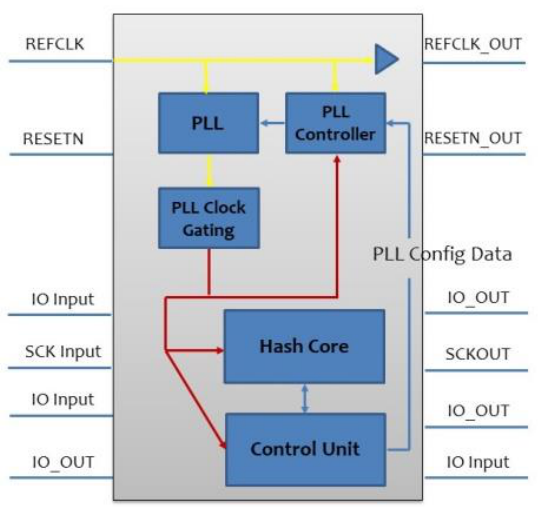
Figure 2. The function block diagram illustrating the functions of the14 nm ASIC.